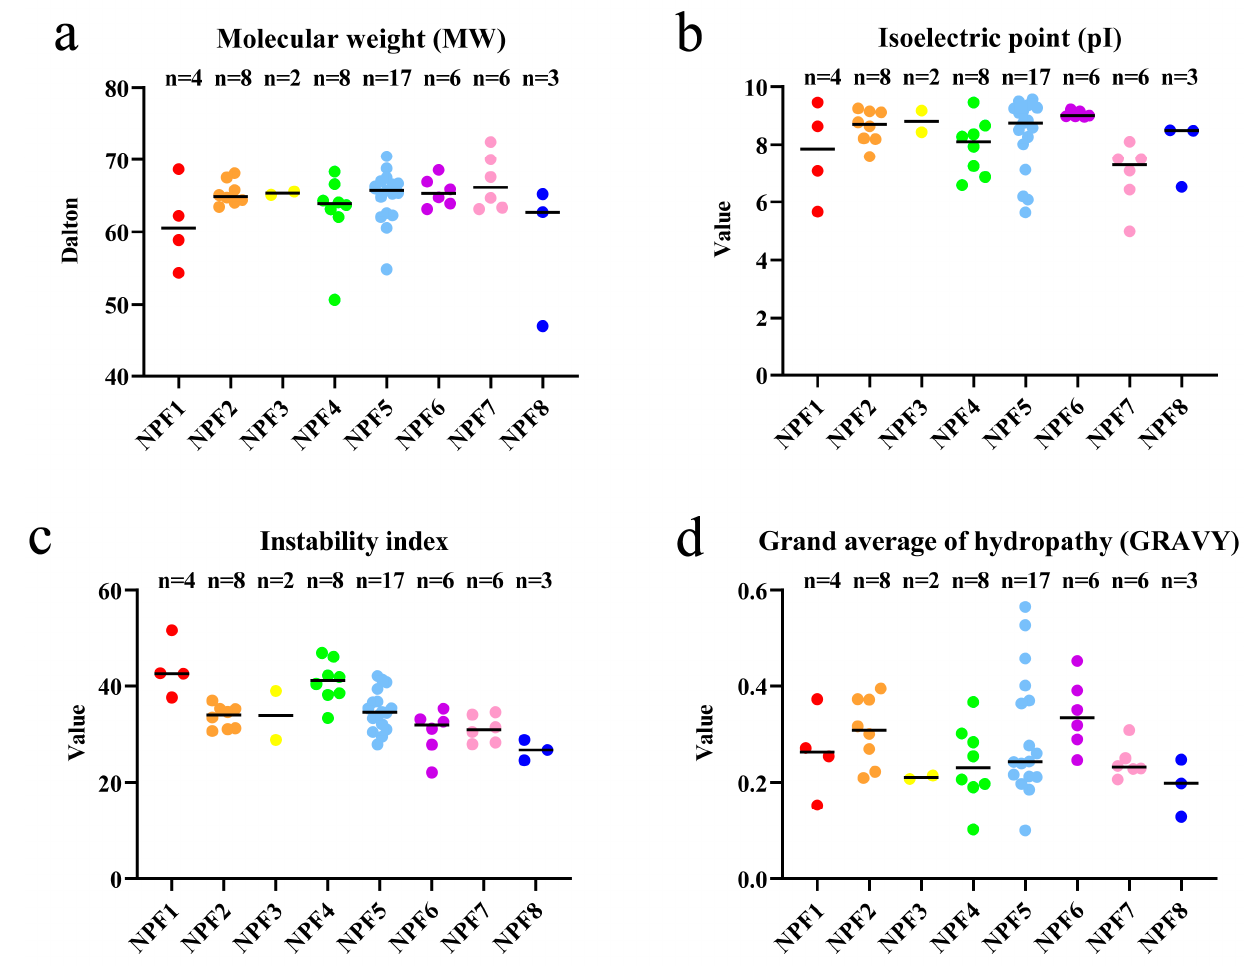
Figure 1. Molecular characterization of NPF proteins in cucumber. ( a ) molecular weight; ( b ) theoretical isoelectric point; ( c ) instability index; ( d ) grand average of hydropathy.